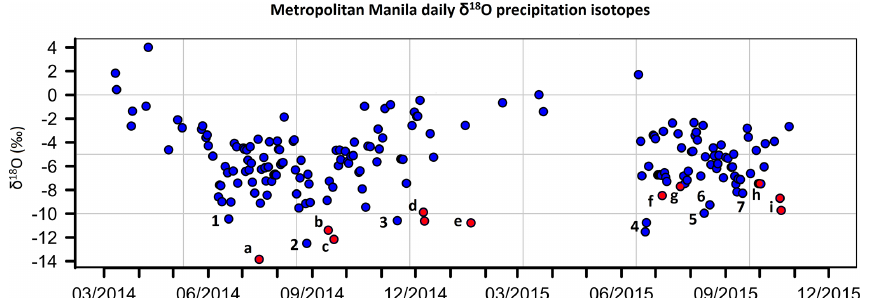
Figure 5. Complete time series of 186 precipitation samples taken between 10 March 2014 and 27 October 2015. δ 18 O data points associated with TC activity are coloured in red. Other anomalously low δ 18 O values were investigated using IMERG satellite precipitation data. Point a: Rammasun, 16 July 2014, − 13 . 84‰, 83mm. Point b: Kalmaegi, 15 September 2014, − 11 . 39‰, 85mm. Point c: Fung-Wong, 20 Septem- ber 2014, − 12 . 16‰, 175mm. Point d: Hagupit, 8–9 December 2014, − 9 . 88‰, − 10 . 62‰, 40mm. Point e: Mekkhala, 19 January 2015, − 10 . 77‰, 22mm. Point f: Linfa, 7 July 2015, − 8 . 5‰, 63mm. Point g: Twelve, 23 July 2015, − 7 . 7‰, 68mm. Point h: Mujigae, 1 Octo- ber 2015, − 7 . 5‰, 51mm. Point i: Koppu, 19–20 October 2015, − 8 . 7‰, − 9 . 72‰, 38, 26mm. Point 1: storm passing by, 19 June 2014, − 10 . 44‰, 6mm. Point 2: large rain areas, 27 August 2014, − 12 . 5‰, 21mm. Point 3: storm passing by, 15 November 2014, − 10 . 58‰, 3mm. Point 4: large rain areas, 22–23 June 15, − 10 . 76‰, − 11 . 52‰, 2, 4mm. Point 5: heavy rainfall, 13 August 2015, − 9 . 96‰, 80mm. Point 6: heavy rainfall, 18 August 2015, − 9 . 26‰, 13mm. Point 7: local convection, 16 September 2015, − 8 . 28‰, 47mm. Please note that the date format in this figure is